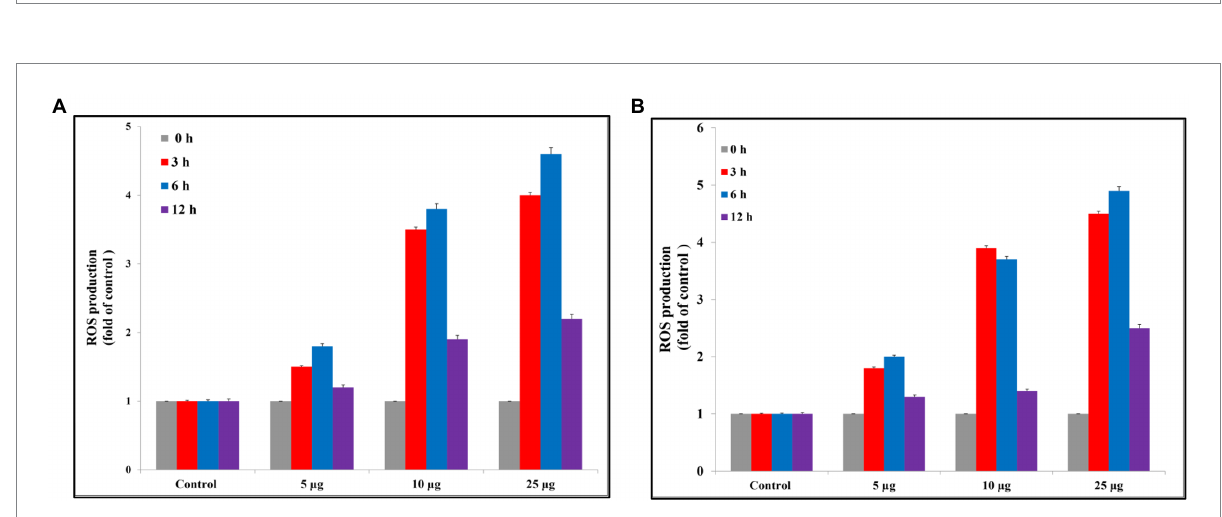
FIGURE 8 Reactive oxygen species assay. (A) Silver magnetite core shell nanoparticle against Escherichia coli. (B) Silver magnetite core shell nanoparticle against Salmonella